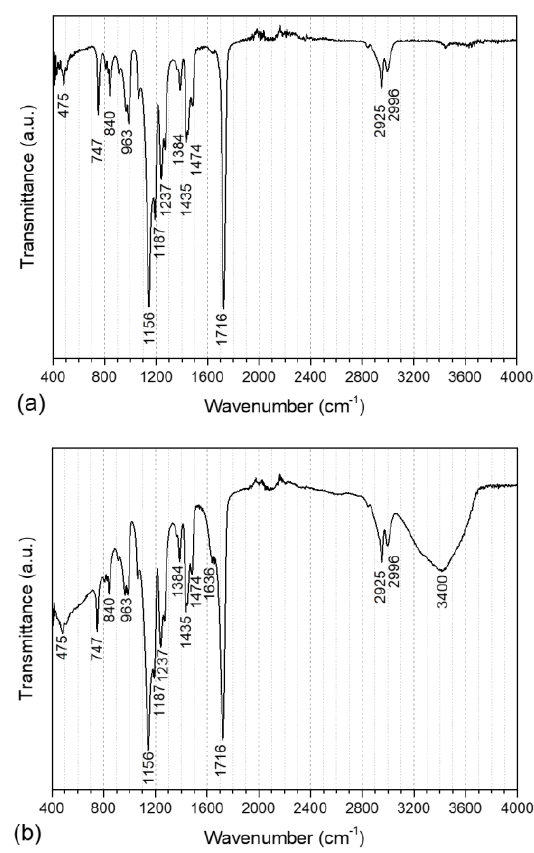
Figure 5. FT-IR spectra of the PMMA core polymer ( a ) and PMMA@P(MAA-co-EGDMA) core-shell copolymer ( b ). Table 1. FT-IR peak analysis.